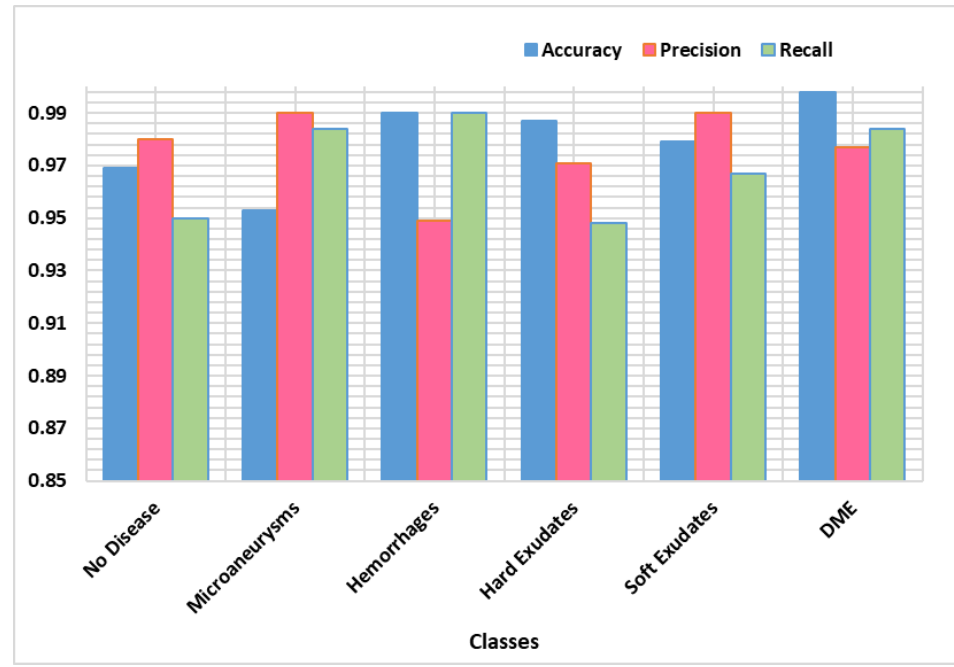
Figure 6. Stage-wise performance of our proposed technique.